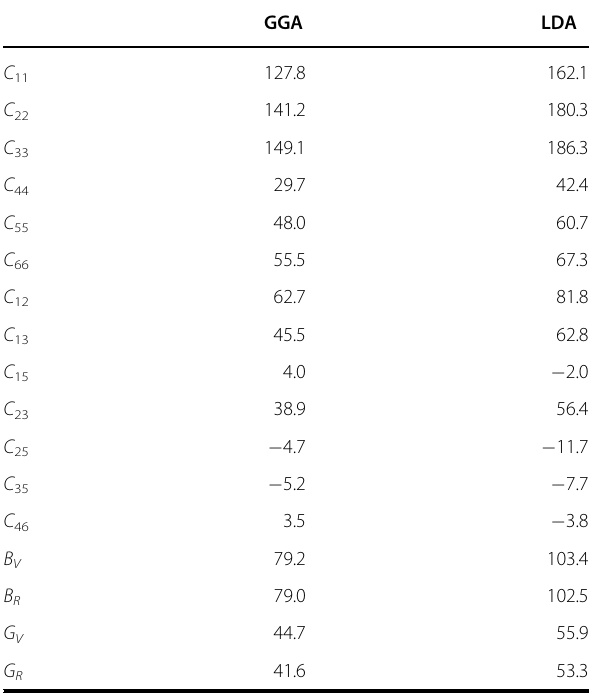
Table 4 Calculated elastic constants (in GPa) for Ca 6 Ba(PO 4 ) 4 O